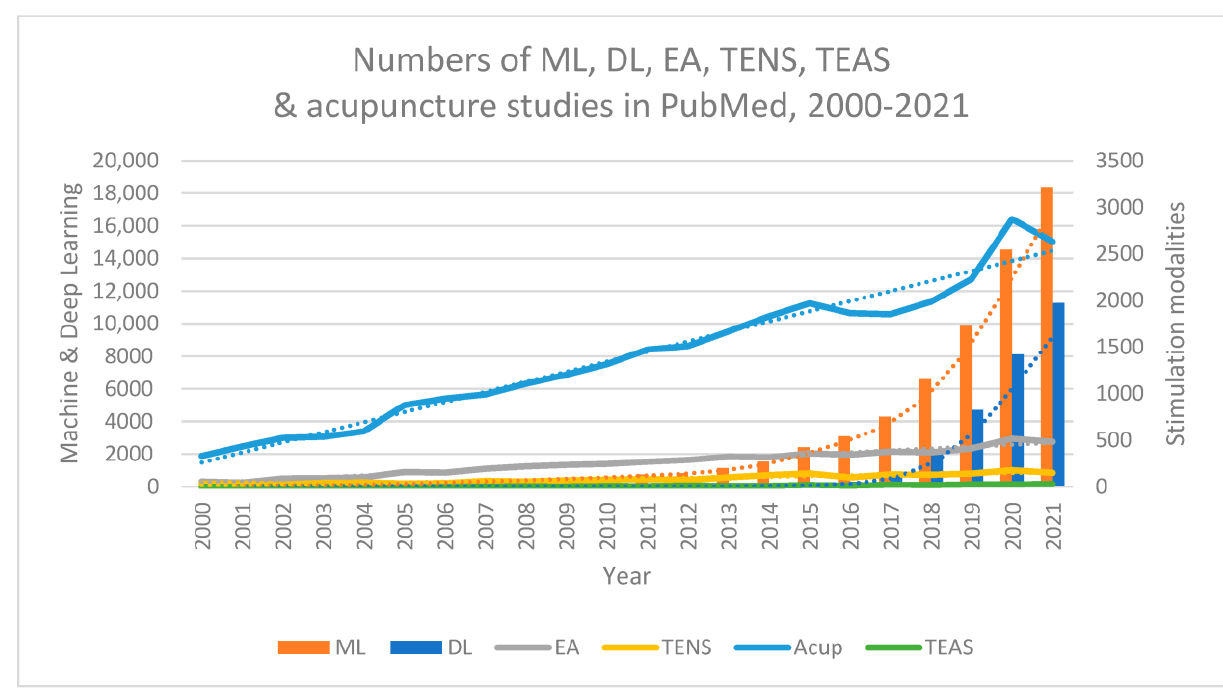
Figure 1. Timelines of research on deep learning (DL), machine learning (ML), acupuncture (Acup), electroacupuncture (EA), transcutaneous electrical nerve stimulation (TENS) and transcutaneous electroacupuncture stimulation (TEAS), 2000–2021. Based on PubMed searches, 6 December 2021.